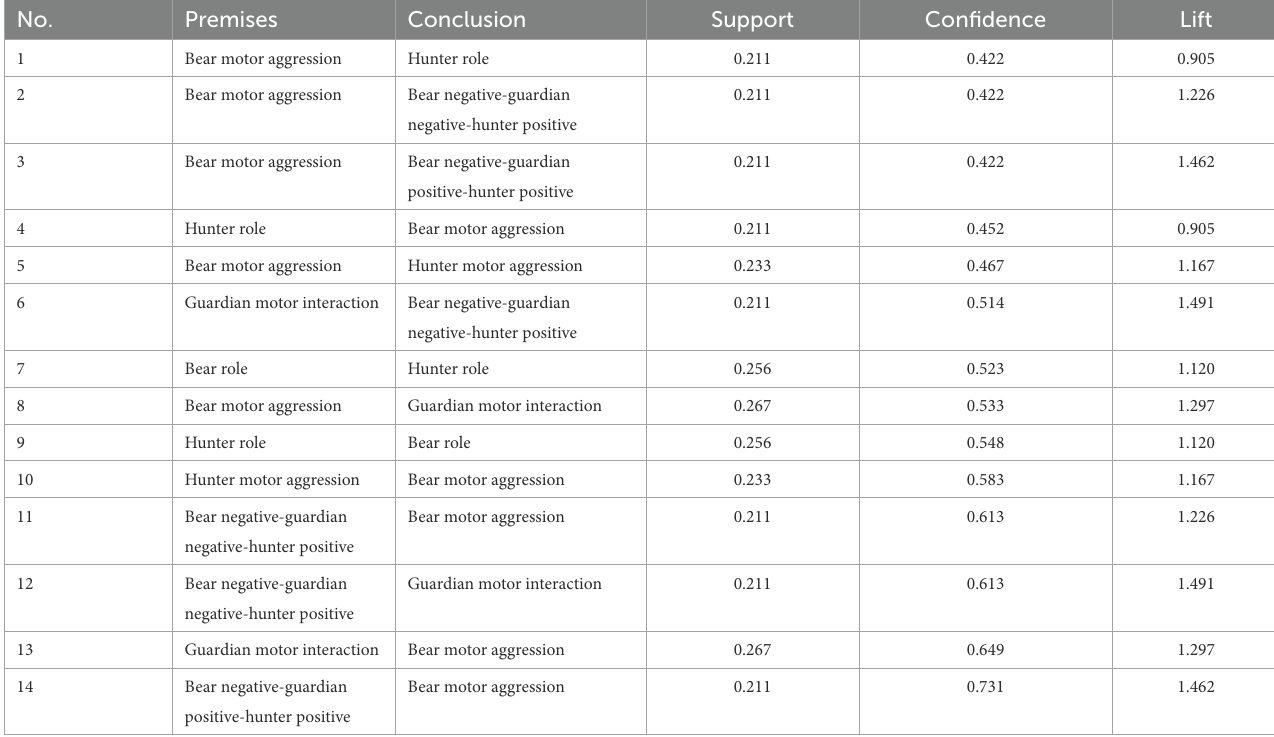
TABLE 2 Pairwise association rules (premises and conclusion) for emotional meanings and emotional triads (according to support, confidence <0.04 and lift indicators).